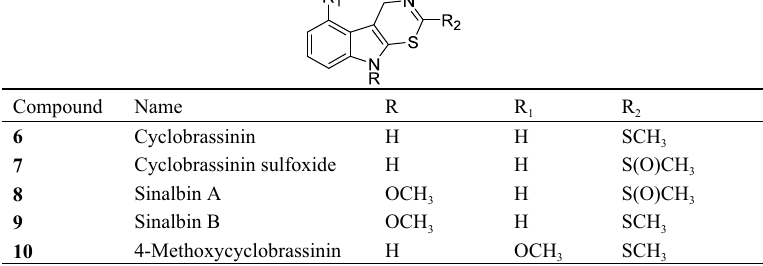
Fig. 3: Cyclobrassinin ( 6 ), cyclobrassinin sulfoxide ( 7 ), sinalbins A and B ( 8 and 9 ) and 4-methoxycyclobrassinin ( 10